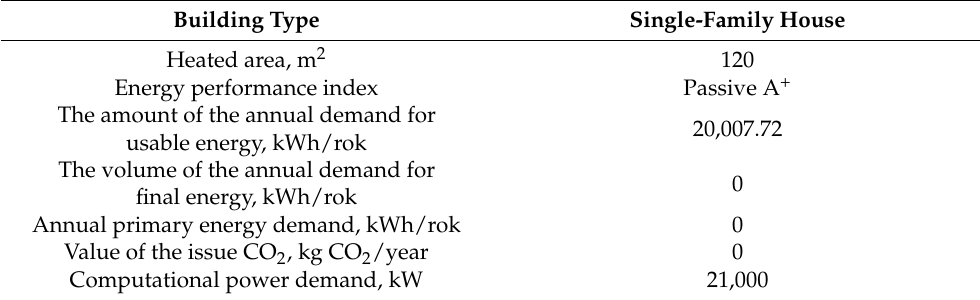
Table 14. Building energy parameters after using an induction boiler. Building Type Single-Family House Heated area, m 2 120 Energy performance index Passive A